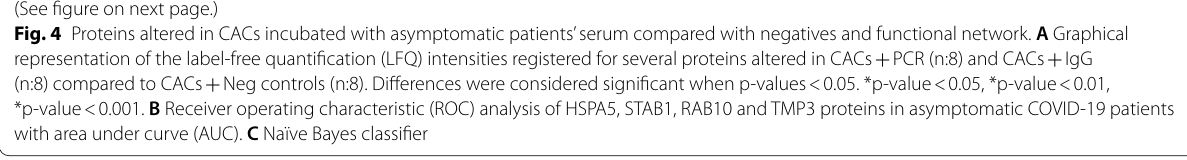
PCR (n:8) and CACs IgG + +